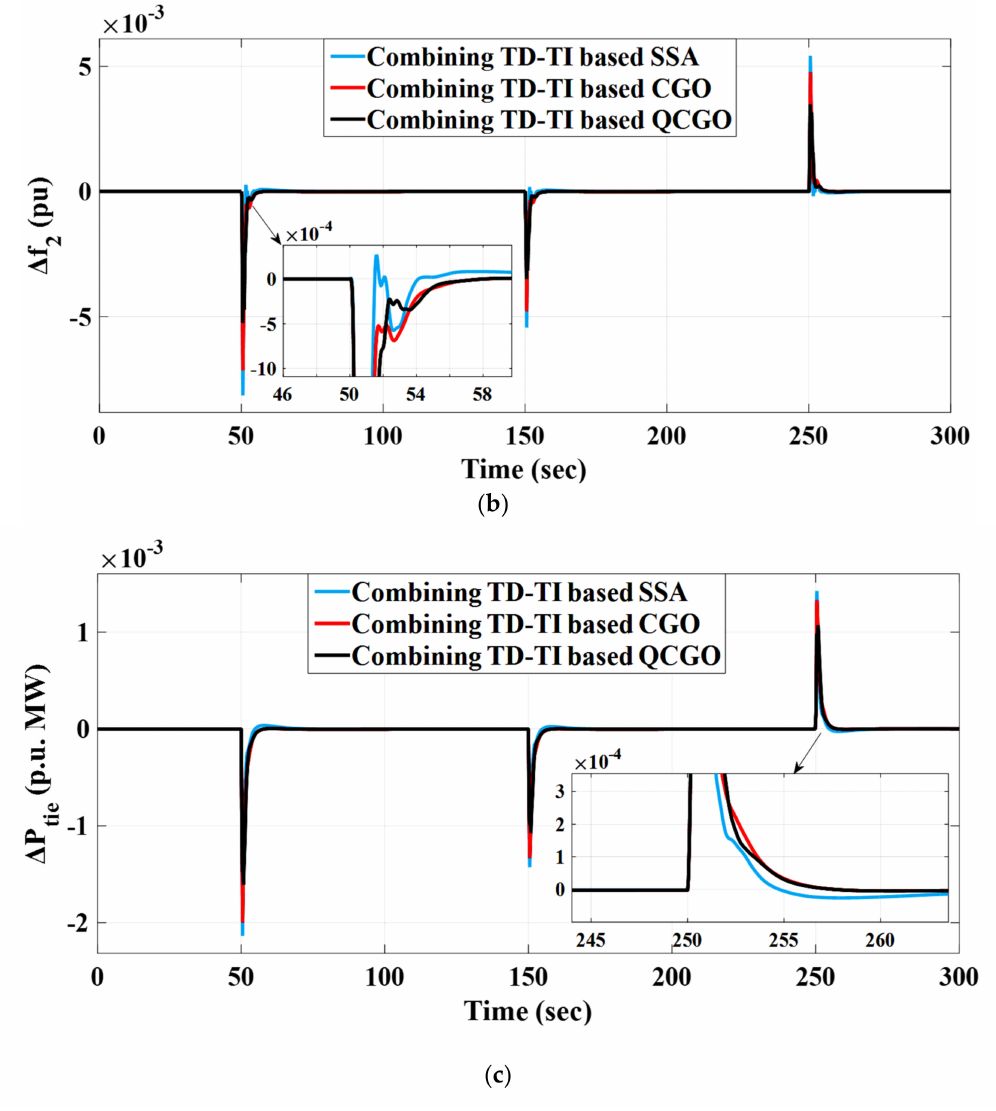
Figure 18. Dynamic power grid responses in case A.2: ( a ) ∆ f